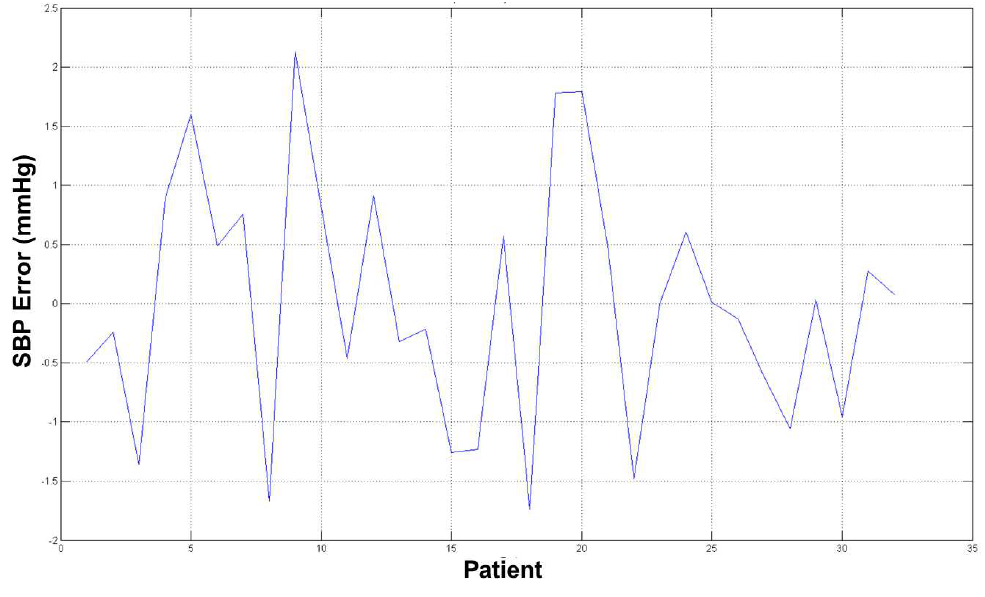
Figure 12. SBP estimation error